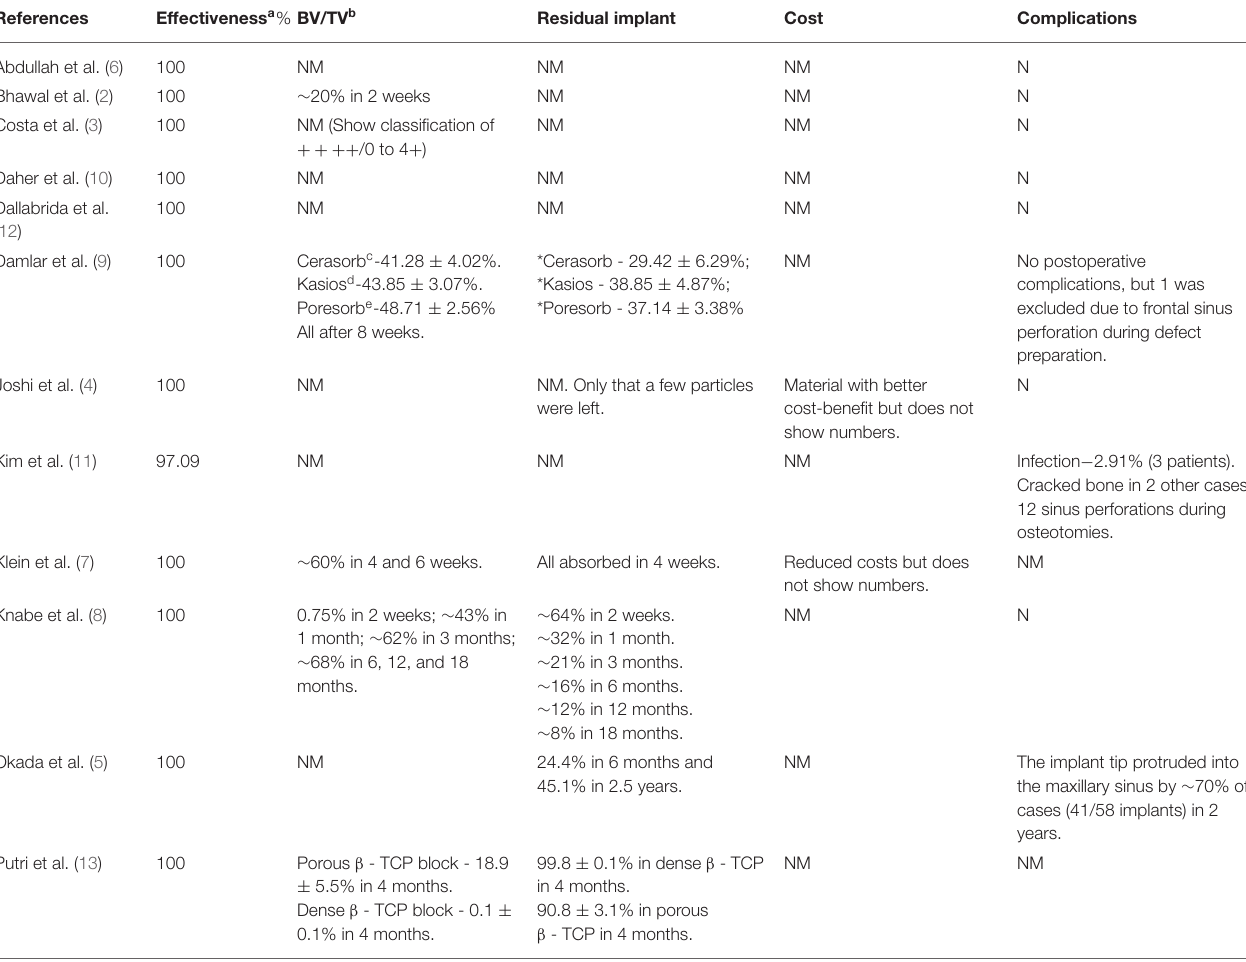
TABLE 3 | Effectiveness of β - TCP implant shown through newformed bone, volumetric density, bone mass content, and residual graft demonstrated in some articles.